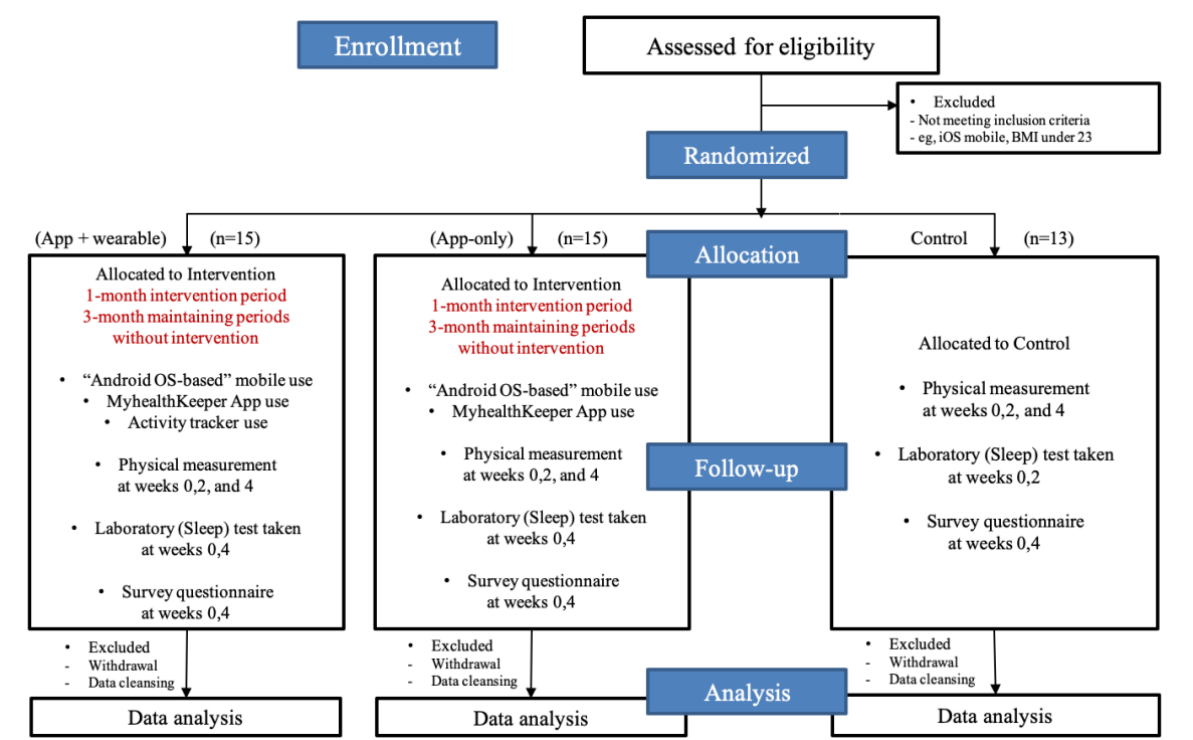
Figure 1. Clinical trial study design. BMI: body mass index; OS: operating